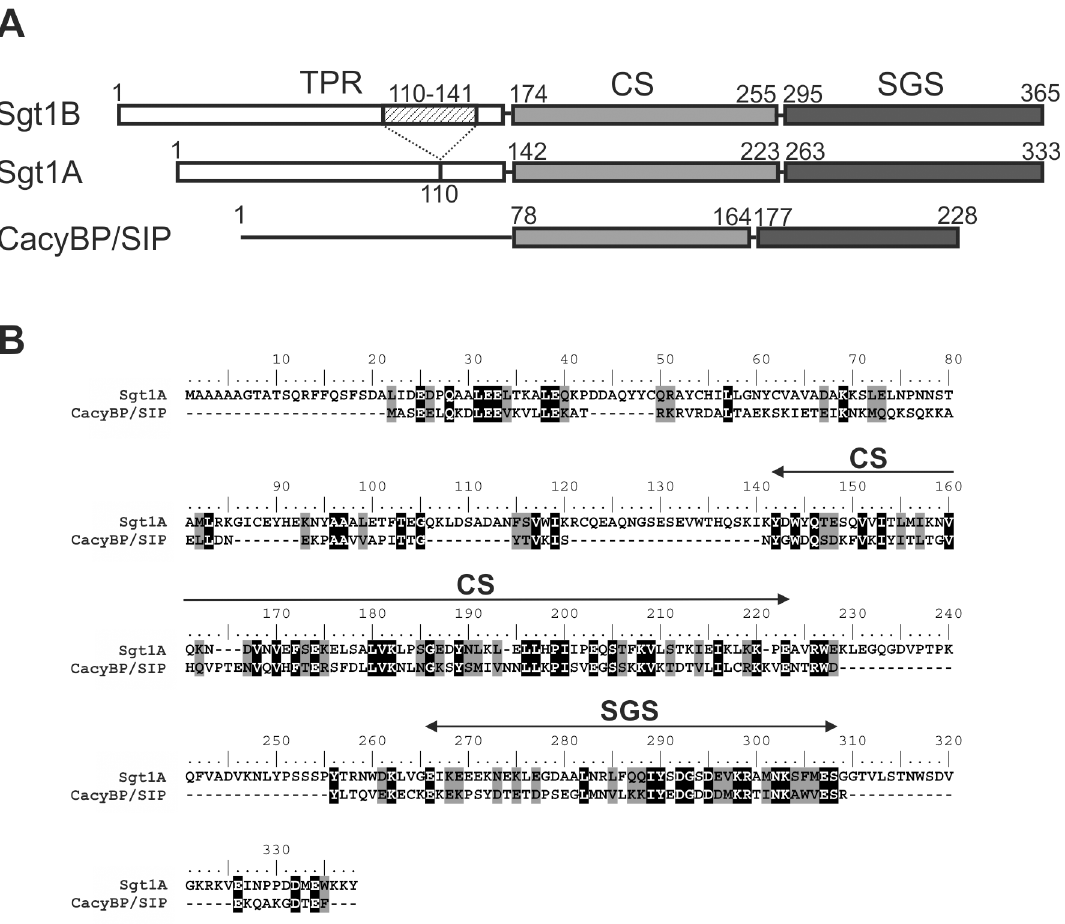
Fig 1. Comparison of human Sgt1 and CacyBP/SIP. (A) Schematic representation of CacyBP/SIP and both isoforms of Sgt1 (Sgt1A and Sgt1B). Grey and black boxes show the CS (CHORD-containing proteins and Sgt1) and the SGS (Sgt1-specific) domains. Hatched box indicates the fragment of sequence specific for Sgt1B. (B) Sequence alignment of CacyBP/SIP and Sgt1A. The sequences were compared using ClustalW software. Black and grey boxes indicate identical and similar amino acid residues, respectively. The amino acid identity and similarity in the SGS domain are 29.3% and 63.4%, respectively, and in the CS domain are 36.8% and 55.2%,